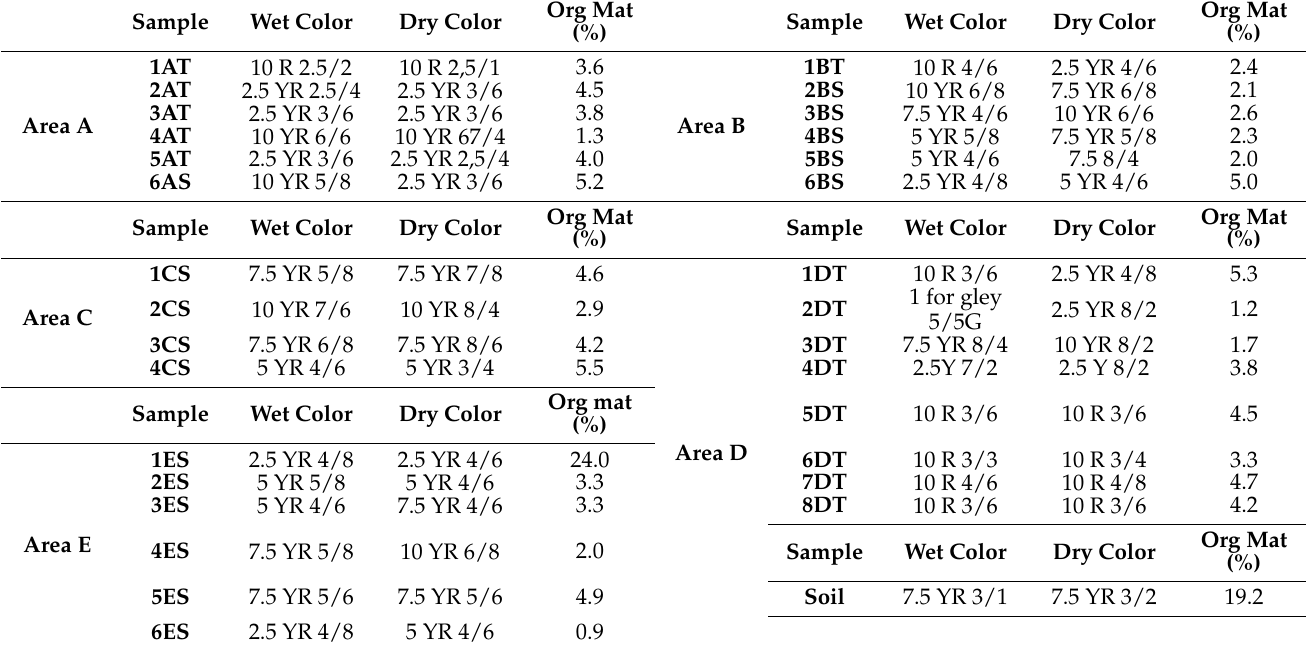
Table 1. Color for the wet and dry samples according to the Munsell System and organic matter content in all the studied